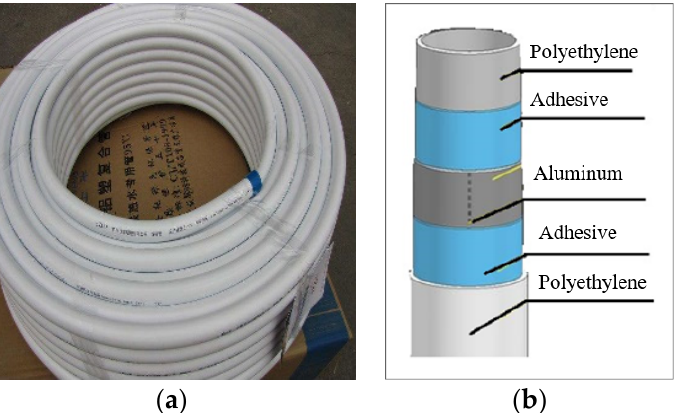
Figure 3. Structure of the aluminum–plastic composite pipe: ( a ) front view; ( b ) sectional view.